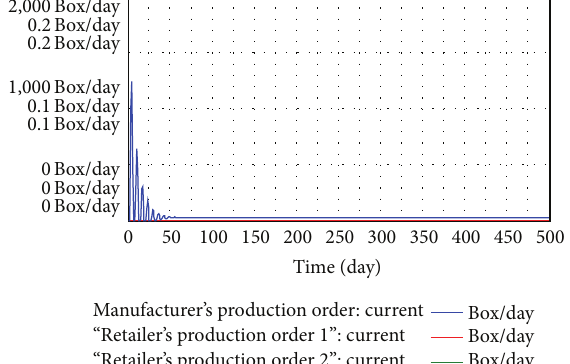
Figure 7: The members’ order quantity changes when recycler reaction coefficient is